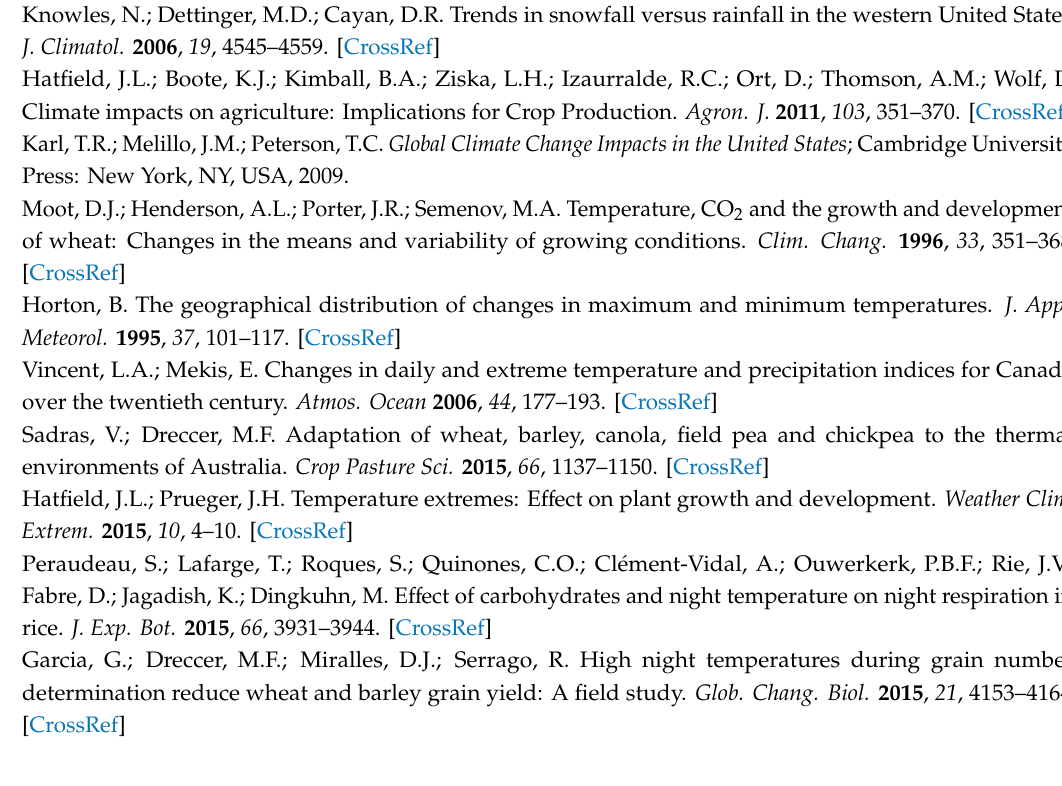
Table S1: LSMeans from control environments for agronomic traits † in a panel of 36 soft red winter wheat genotypes, Lexington, KY, 2015. Mean, coe ffi cient of variation (CV), and standard error (SE) from ANOVA, Table S2: LSMeans for control environment for nitrogen traits † for a panel of 36 soft red winter wheat genotypes, Lexington, KY, 2015. Mean, coe ffi cient of variation (CV), and standard error (SE) from ANOVA, Table S3: LSMeans from passive warmed environments for agronomic traits † in a panel of 36 soft red winter wheat genotypes, Lexington, KY, 2015. Mean, coe ffi cient of variation (CV), and standard error (SE) from ANOVA, Table S4: LSMeans for passive warmed environment for nitrogen traits † for a panel of 36 soft red winter wheat genotypes, Lexington, KY, 2015. Mean, coe ffi cient of variation (CV), and standard error (SE) from ANOVA, Table S5: LSMeans from control environments for agronomic traits † in a panel of 36 soft red winter wheat genotypes, Lexington, KY, 2016. Mean, coe ffi cient of variation (CV), and standard error (SE) from ANOVA, Table S6: LSMeans for control environment for nitrogen traits † for a panel of 36 soft red winter wheat genotypes, Lexington, KY, 2016. Mean, coe ffi cient of variation (CV), and standard error (SE) from ANOVA, Table S7: LSMeans from passive warmed environments for agronomic traits † in a panel of 36 soft red winter wheat genotypes, Lexington, KY, 2016. Mean, coe ffi cient of variation (CV), and standard error (SE) from ANOVA, Table S8: LSMeans for passive warmed environment for nitrogen traits † for a panel of 36 soft red winter wheat genotypes, Lexington, KY, 2016. Mean, coe ffi cient of variation (CV), and standard error (SE) from